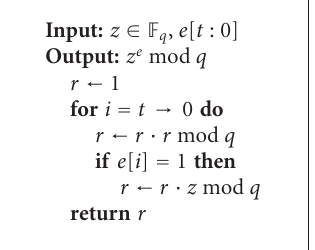
Algorithm 1: Square and multiply modular exponentiation [24].